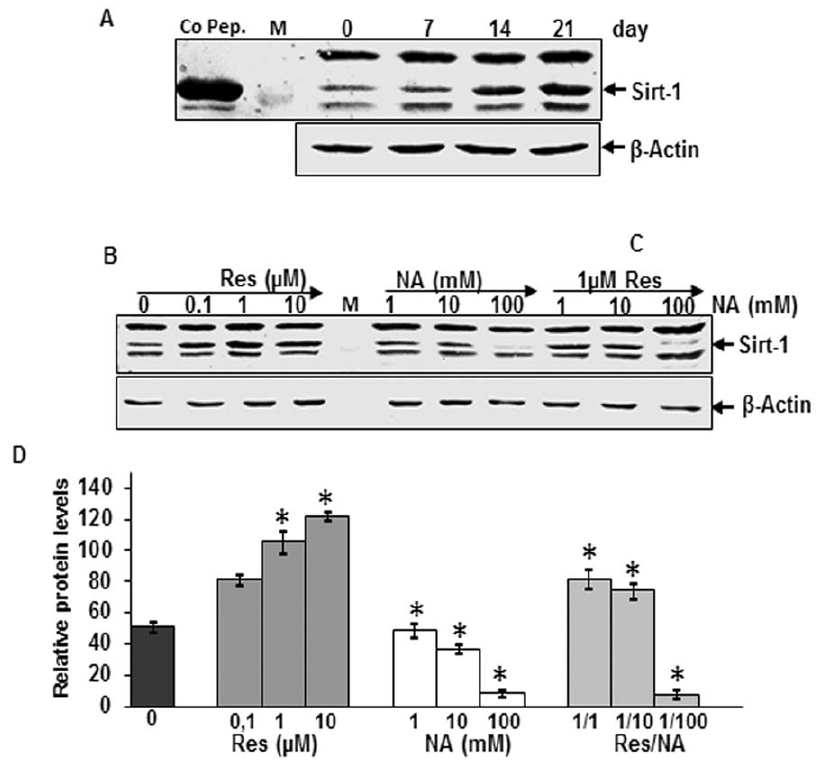
Figure 4. Effect of resveratrol on nicotinamide-induced inhibition of Sirt-1 expression. A: Sirt-1 protein expression during osteogenesis in monolayer cultures. 21 days monolayer cultures of osteogenic induced fat tissue derived MSCs. Whole cell lysates (500 ng/lane) were probed for Sirt-1. MSCs express high levels of Sirt-1 before and after induction of osteogenic differentiation. Synthesis of the housekeeping protein b -actin was unaffected. Sirt-1 control peptide was used as a control (co pep.). M=Marker for molecular weights. B–C: Effect of resveratrol on NA-induced inhibition of Sirt-1 expression during osteogenesis in monolayer culture. 14 days osteogenic induction culture of control MSCs, cells treated with 0.1, 1, 10 m M resveratrol or with 1, 10, 100 mM nicotinamide or pre-treated with 1 m M resveratrol for 4 h followed by co-treatment with nicotinamide. Whole cell lysates (500 ng/lane) were fractionated and subjected to western blotting with antibodies against Sirt-1. D: Densitometric evaluation was performed for Sirt-1 expression from Fig. B–C. Each experiment was performed in triplicate and mean values and standard deviation are indicated. Values were compared to the control and statistically significant values with p , 0.05 were designated by an asterisk (*).